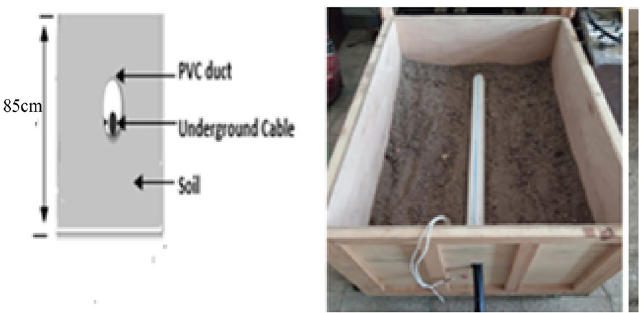
Fig. 6 Schematic design of laying cable in PVC duct